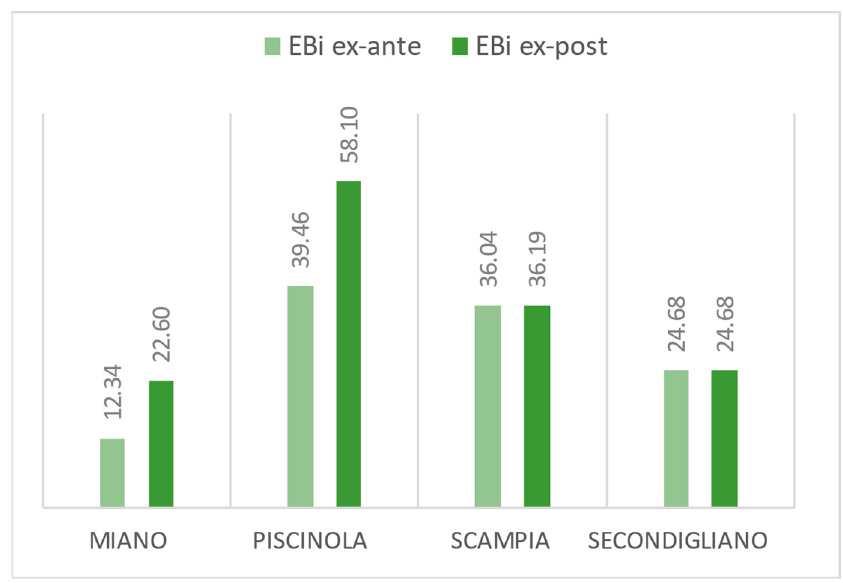
Figure 11. Analysis of the ecological benefit index following the second intervention strategy test- ing.